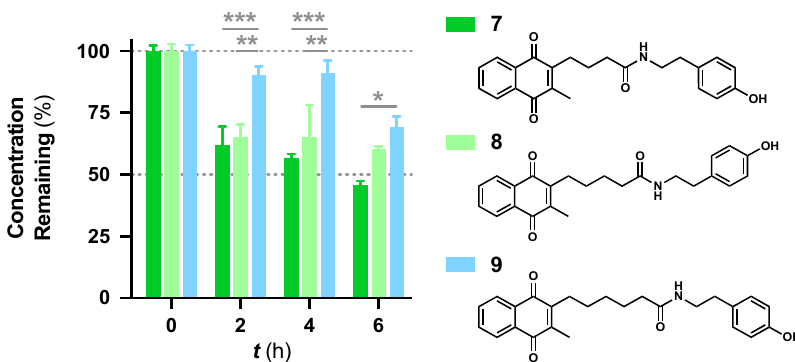
Figure 2. Comparison of metabolic stability and carbon chain length between the quinone core and the amide linkage for the structurally similar tyramine derivatives 7 – 9 . Data was expressed as mean ± SEM from at least one experiment, with at least three data points each: *** p < 0.001, ** p < 0.002, * p < 0.033.